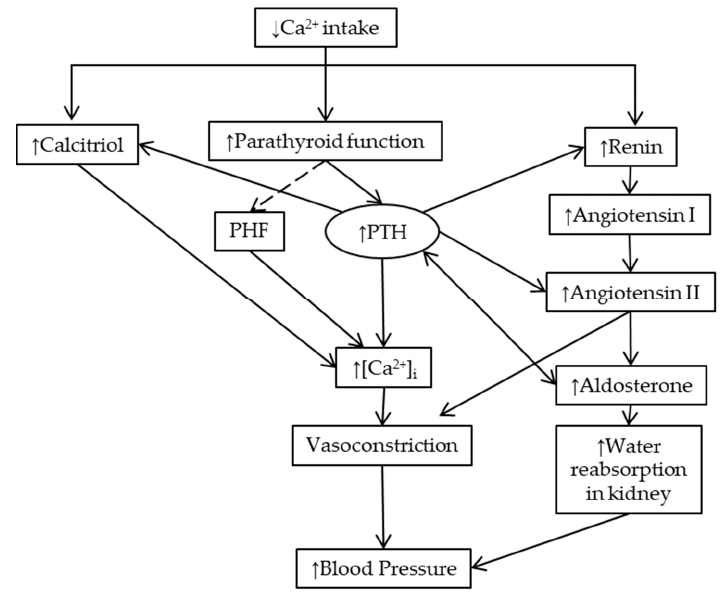
Figure 3. Scheme of the mechanisms involved in the rise of blood pressure due to low calcium intake, namely the link between calciotropic hormones and blood pressure regulators. Low calcium intake: (a) increases calcitriol serum levels, (b) stimulates parathyroid function, and (c) increases renin secretion. Calcitriol may increase cytosolic free calcium concentration ([Ca 2+ ] i ) via non-genomic short-term mechanisms. The parathyroid gland secretes parathyroid hormone (PTH) and possibly (dash arrow) the parathyroid hypertensive factor (PHF). Both mediators increase [Ca 2+ ] i , leading to the contraction of the vascular smooth muscle cells (vasoconstriction). Renin release is stimulated both by low extracellular calcium and PTH, activating the renin–angiotensin–aldosterone system (RAAS). In addition, PTH increases angiotensin II and aldosterone synthesis, which also leads to vasoconstriction and increases renal water reabsorption, increasing blood pressure. Aldosterone also increases PTH serum levels (double-headed arrow). See text for further details.